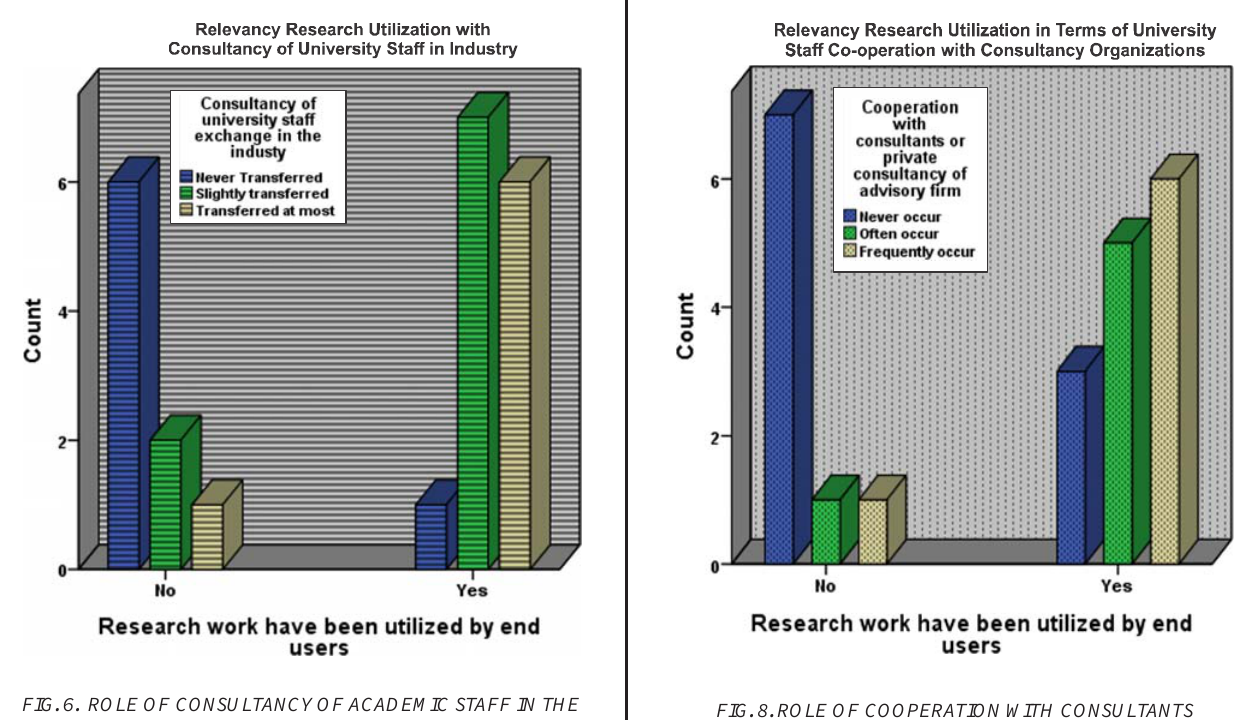
FIG. 8. ROLE OF COOPERATION WITH CONSULTANTS TOWARDS UTILIZATION OF KNOWLEDGE